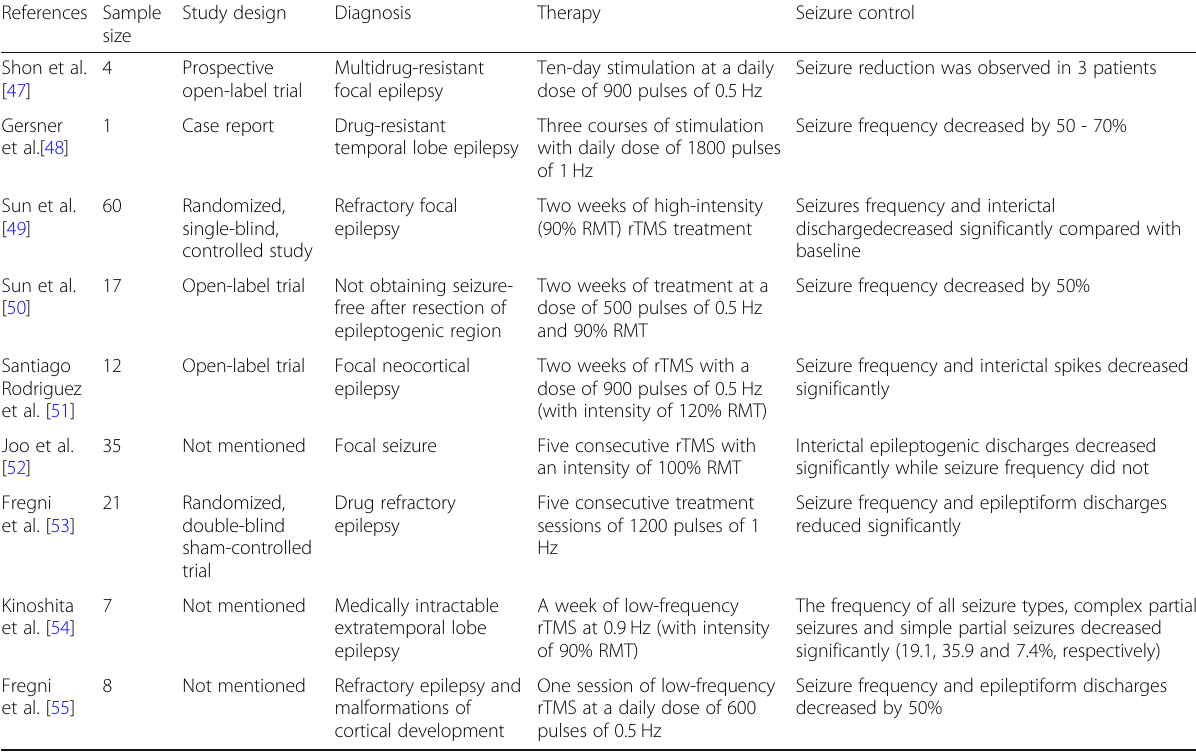
Table 1 Therapeutic effects of rTMS on drug-resistant